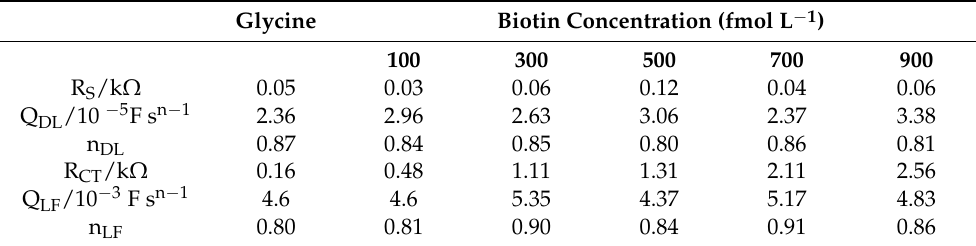
Table 2. Parameters’ values obtained by EIS to PPy e PPy/AuNPs after fitting, R 2 > 0.98.